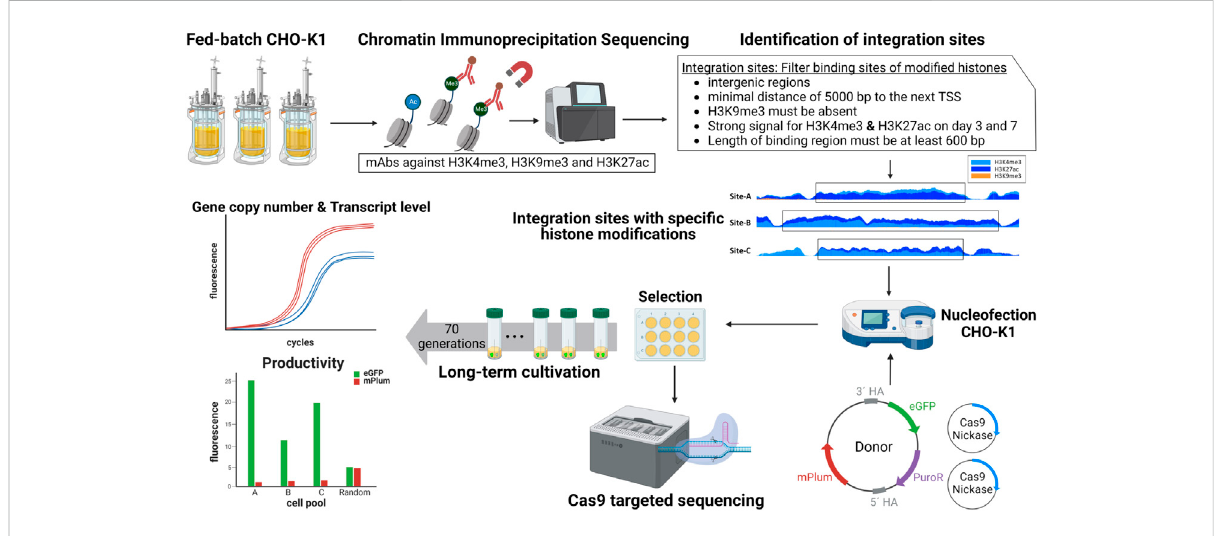
FIGURE 1 Overview of the work fl ow for the identi fi cation and analysis of site-speci fi c integration into regions with speci fi c histone modi fi cations for enhanced transgene